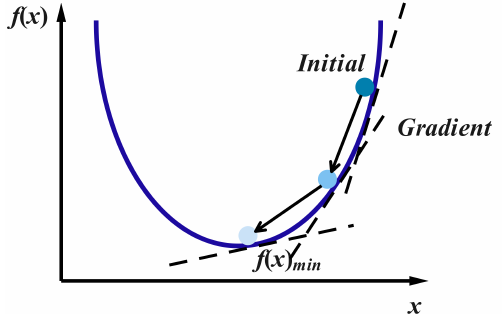
Figure 7. Schematic diagram of stochastic gradient